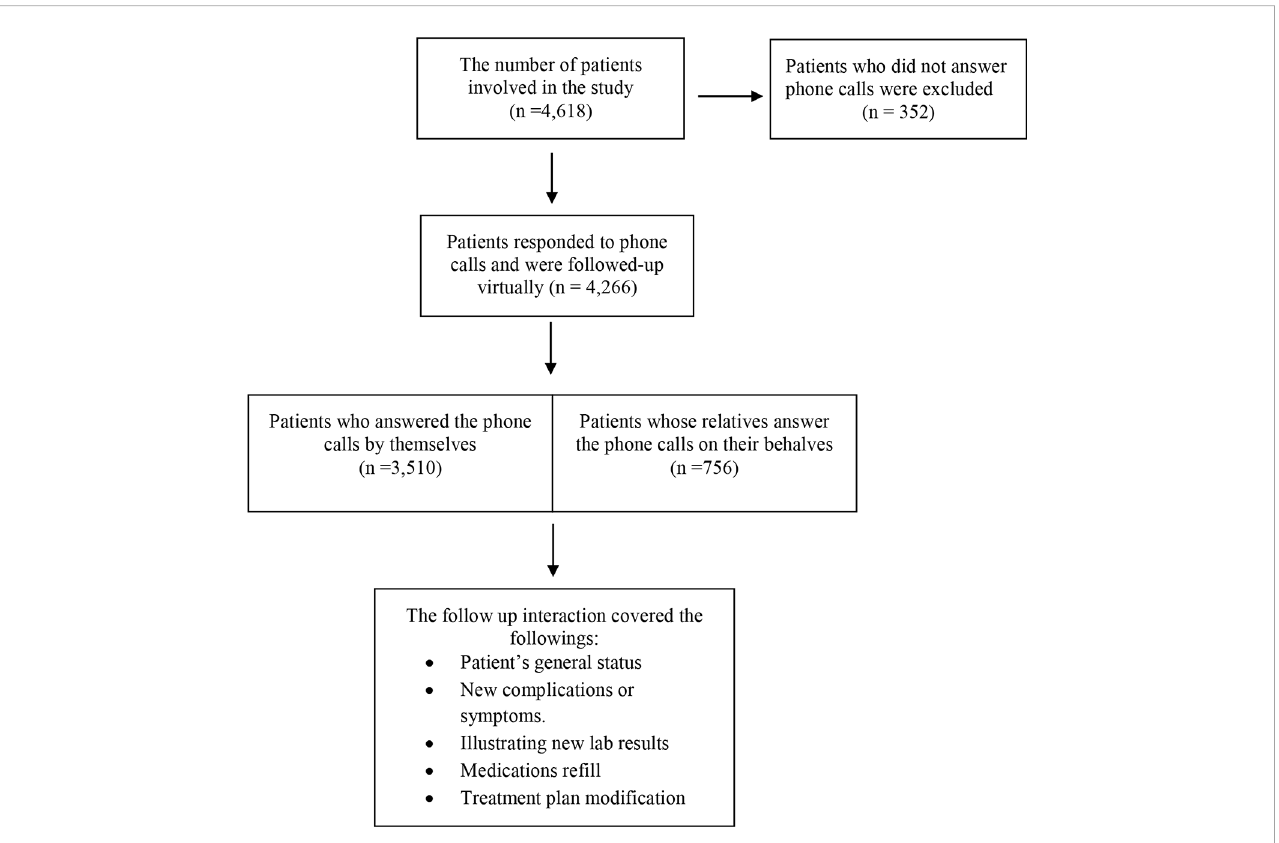
FIGURE 1 PRISMA fl owchart illustrating the patients involved in virtual